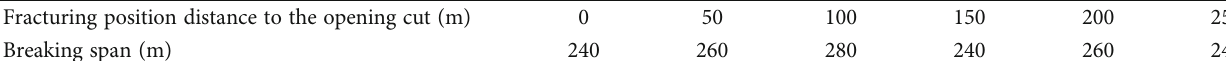
Table 4: The fi rst breaking span under di ff erent fracturing positions.